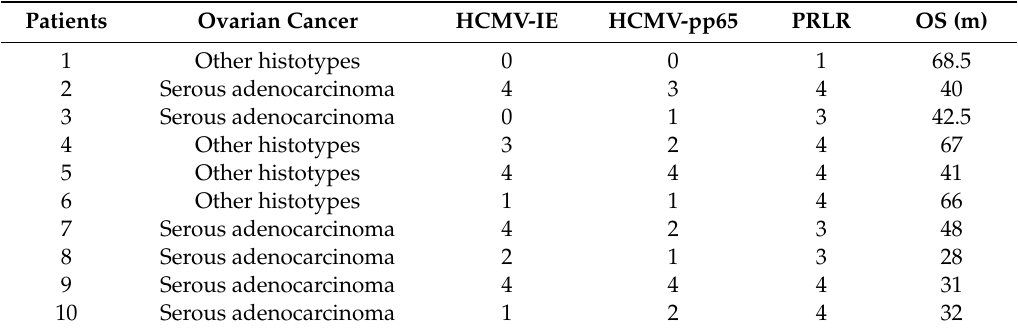
Table 1. Summarized data on expression of HCMV-IE, pp65, PRL, and PRLR in ovarian tumor